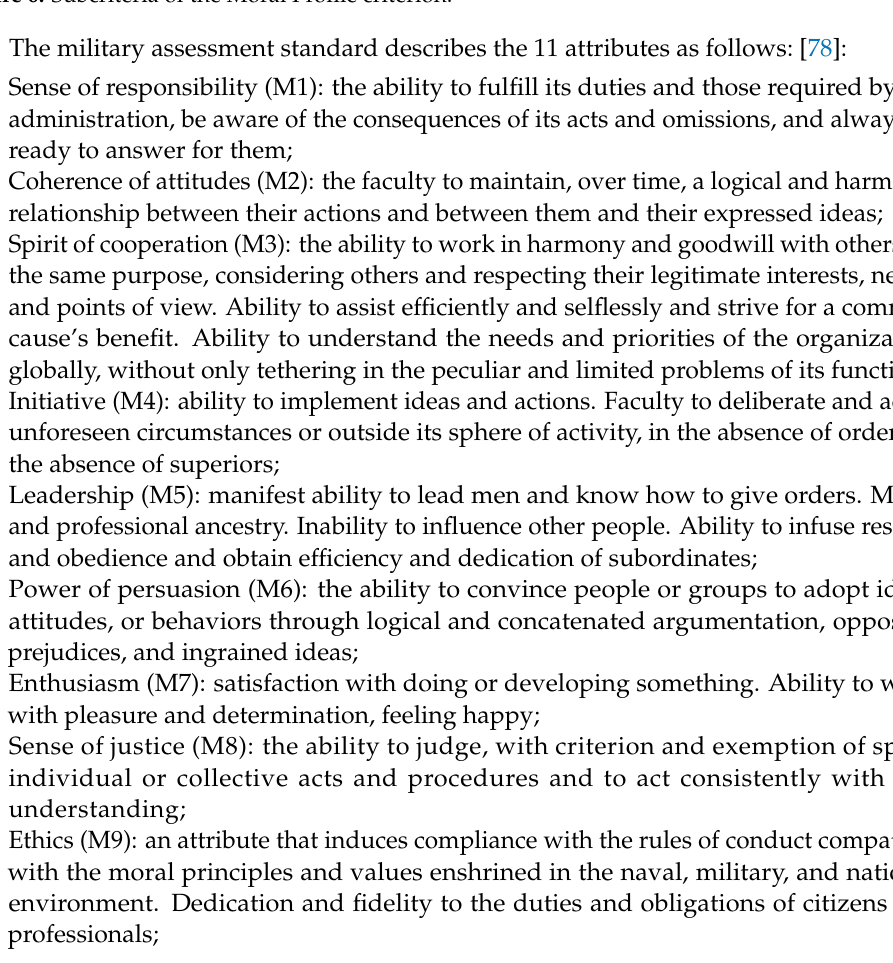
Figure 6. Subcriteria of the Moral Profile criterion.